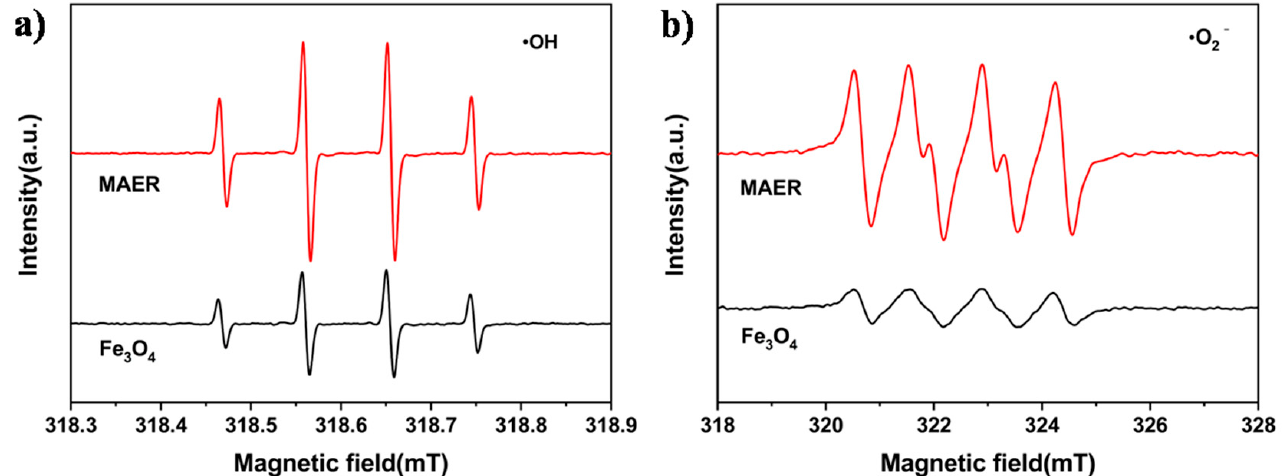
Figure 5. Electron spin resonance (ESR) spectra of different catalytic systems using 5,5-dimethyl-1-pyrroline N-oxide (DMPO) spin-trapping: ( a ) • OH and ( b ) • O 2 − . Reaction conditions: C 0, X-3B = 50 mg/L, [Material] = 0.25 g/L, [H 2 O 2 ] = 150 mM, [DMPO] = 100 mM, T = 25 °C, and pH with no adjustment.